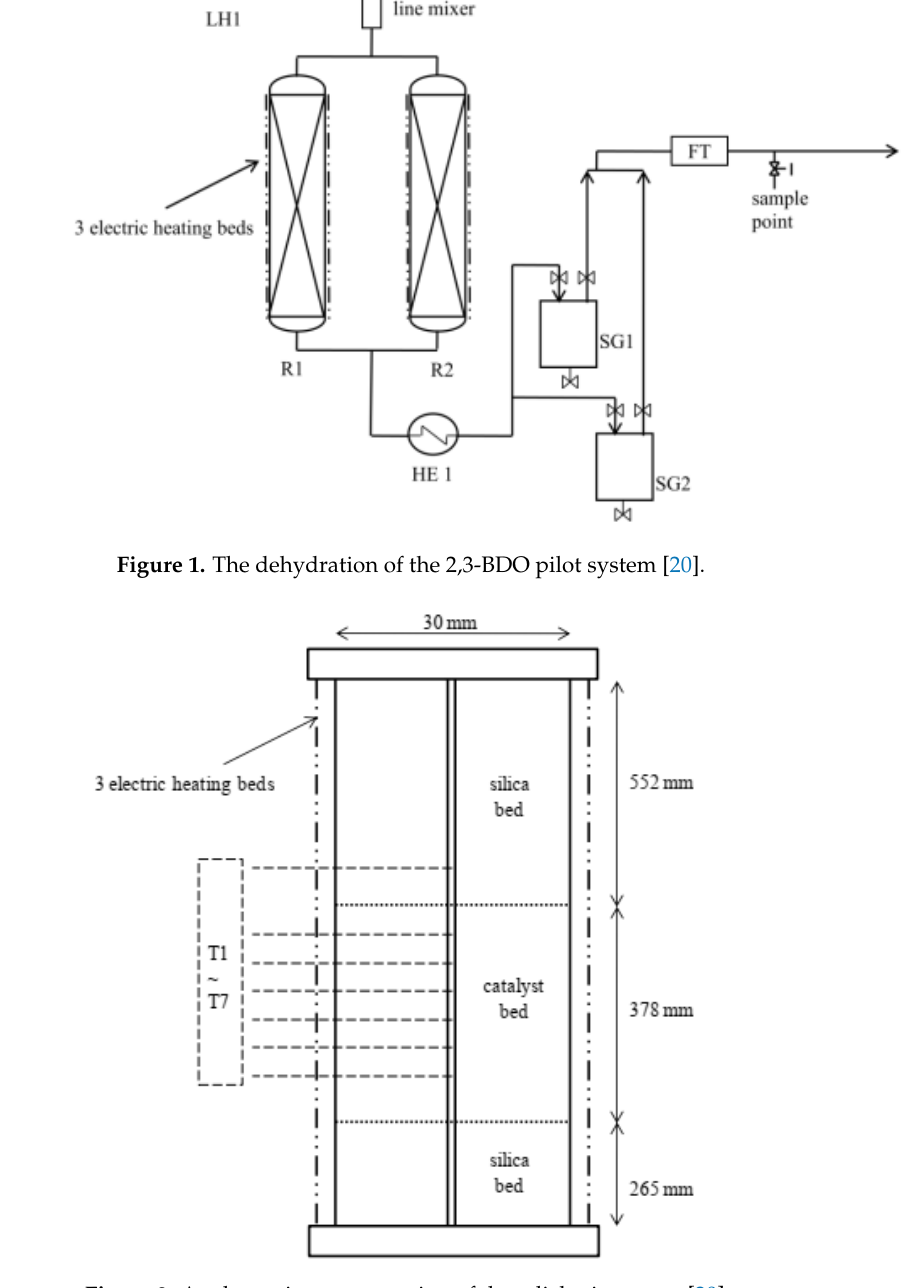
Figure 2. A schematic representation of the adiabatic reactor [20].